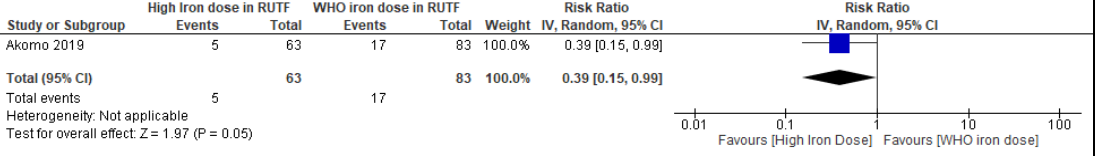
Figure 4. Effect of SMS-based RUTF with high iron content compared to peanut-based RUTF with WHO standard iron content on iron deficiency anemia. The forest plot shows data from a single study and this study had data available only for a subset of population. Akomo 2019 [4]. has two study groups. We included data from milk-free soybean, maize and sorghum (FSMS) and a standard